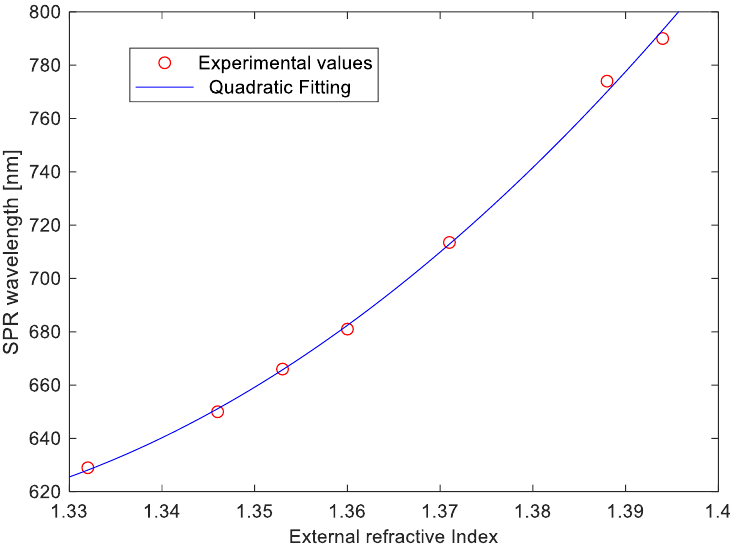
Figure 5. SPR wavelength as a function of the SRI. The circles are extracted from experimental data, while the continuous line is the quadratic fitting curve.